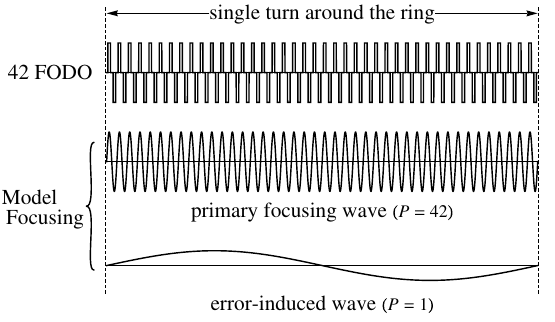
FIG. 2. Radio-frequency waveform employed for resonance crossing experiments with S-POD. Each sinusoidal period approximately represents a single FODO cell. When we consider a circular machine consisting of 42 FODO cells ( P ¼ 42 ), the weak lattice symmetry breakdown due to random gradient errors can be modeled roughly by adding another sinusoidal field ( P ¼ 1 ) whose wavelength is 42 times the single FODO